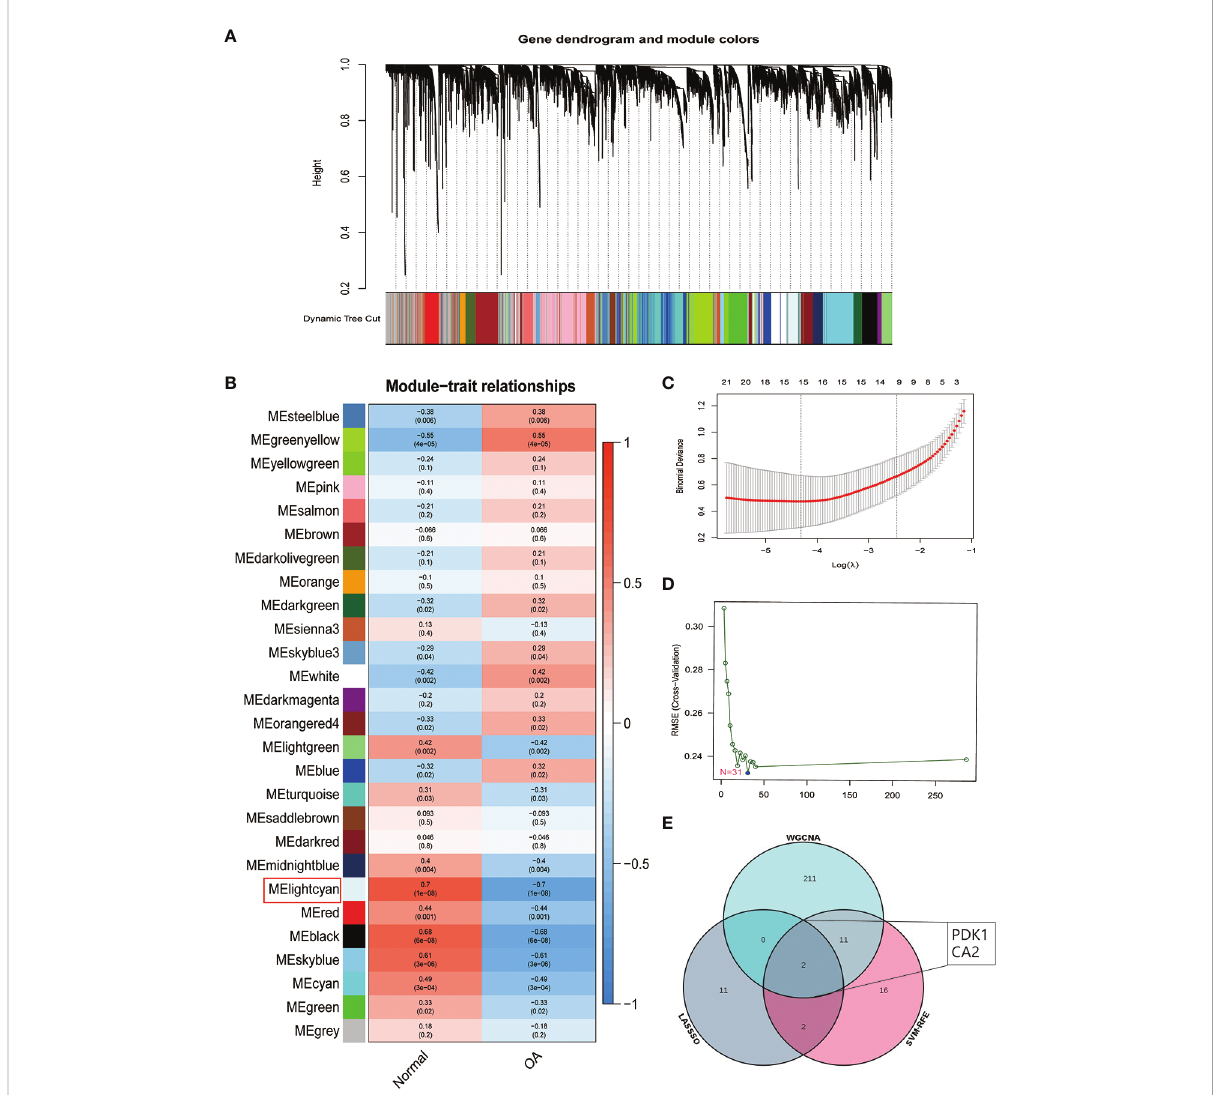
FIGURE 4 Identi fi cation of OA signature genes. (A) Module trait-related tree diagram in WGCNA. In the tree diagram, the top half is a hierarchical clustering diagram of genes, and the bottom half is a diagram of gene modules, with the top and bottom corresponding to each other. (B) Visualization of gene modules associated with OA. Each module is represented by a row and each trait by a column. The leftmost color block represents the module, the rightmost color bar represents the range of correlations, and the two middle columns represent the traits of normal cartilage and OA cartilage, respectively. In the middle heatmap section, the darker the color, the higher the correlation. Red indicates a positive correlation, blue indicates a negative correlation, and the number in each cell indicates the correlation and signi fi cance p -value. (C) The plot of OA disease signature genes was screened using the LASSO regression model. (D) OA disease signature genes identi fi ed by the SVM-RFE algorithm. (E) Venn diagram showing two signature genes (PDK1, CA2) crossed by the WGCNA, LASSO regression, and SVM-RFE